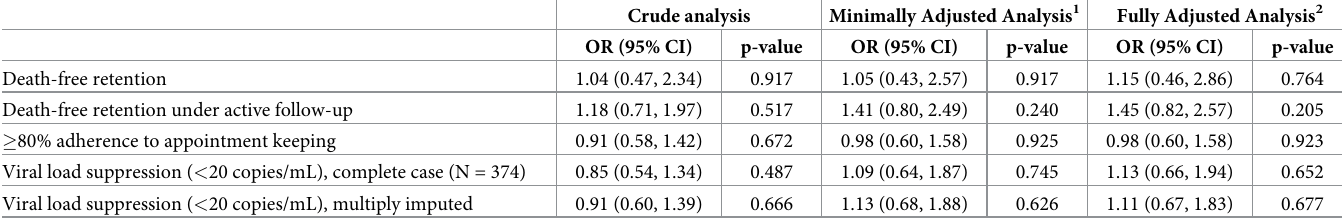
Table 4. Results from generalized mixed models with a logit link and random intercepts for health facility (N =